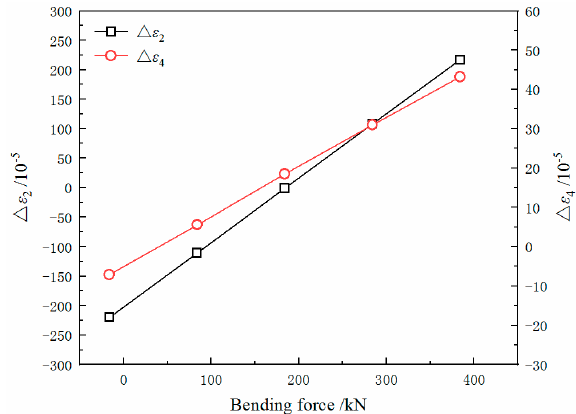
Figure 12. The values of Δ ε 2 and Δ ε 4 with different bending forces.